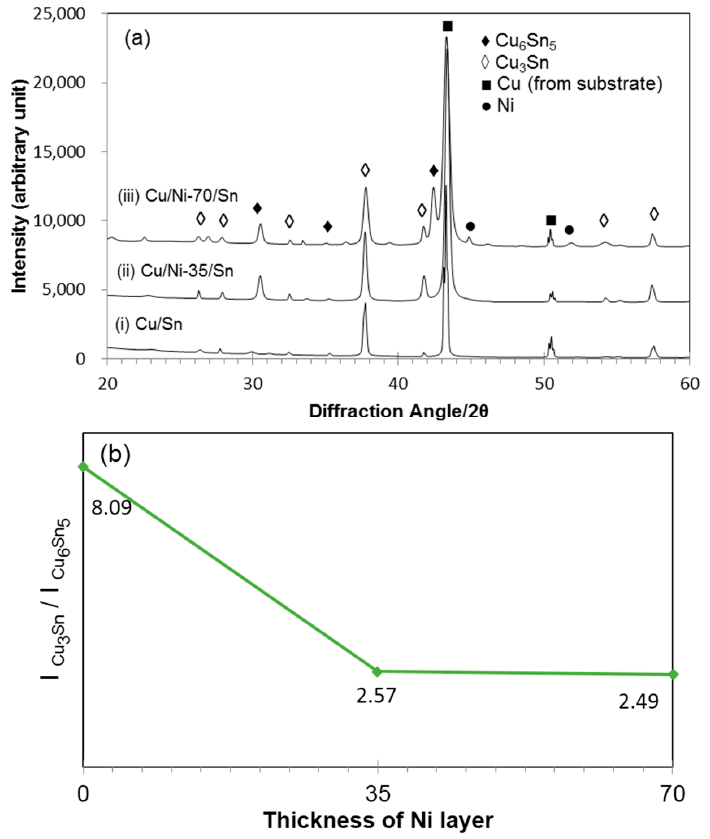
Figure 5. ( a ) XRD patterns for (i) Cu/Sn; (ii) Cu/Ni-35/Sn and (iii) Cu/Ni-70/Sn after reflowing at 300 °C for 60 min and ( b ) ratio of Cu 3 Sn peak intensity to that of Cu 6 Sn 5 peak intensity for Cu/Sn, Cu/Ni-35/Sn, and Cu/Ni-70/Sn after reflow at 300 °C for 60 min.